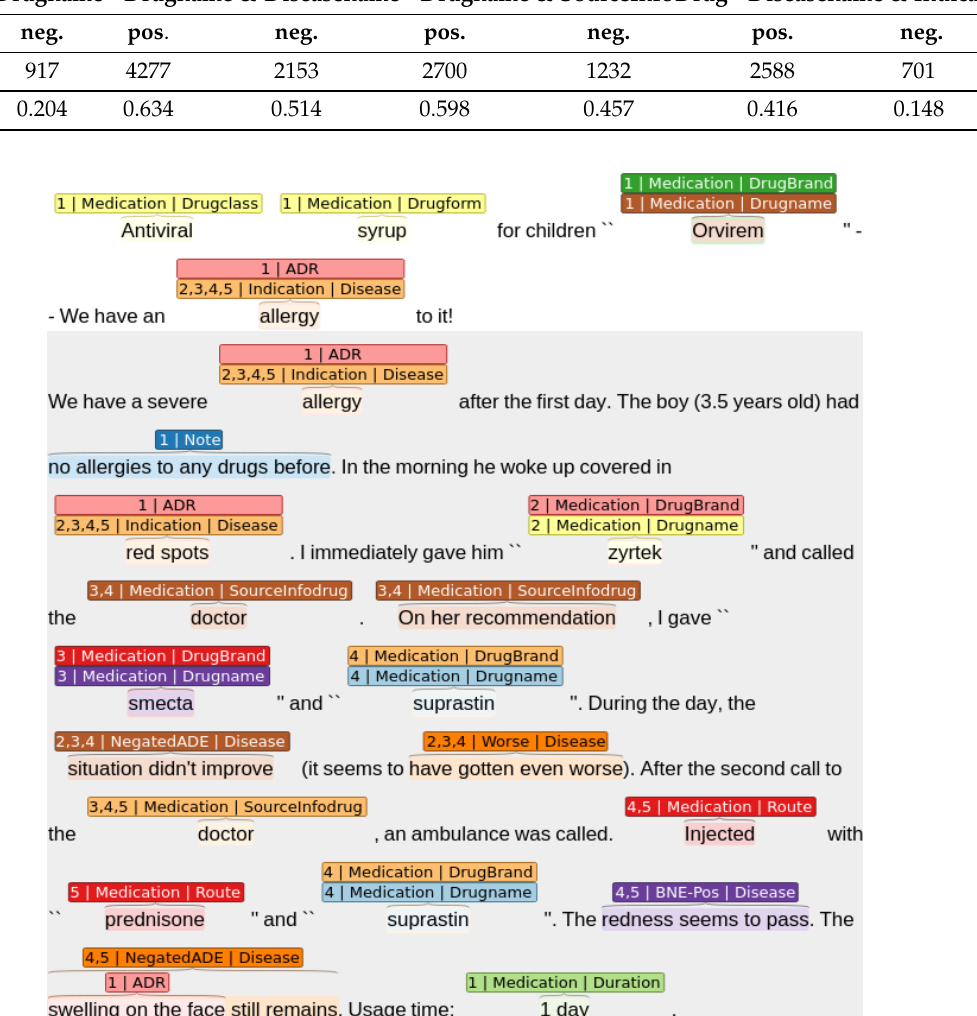
Figure 1. Example of an annotated review. The labels contain, from left to right: context number, entity type, attribute within the entity